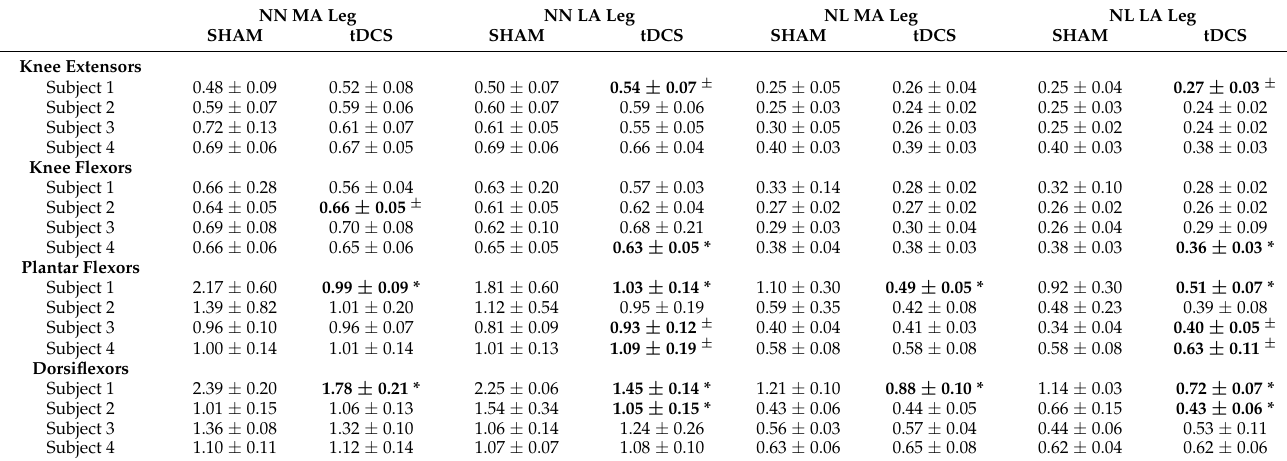
Table 2. Glucose standardized uptake values (SUV in g/mL) in leg muscle groups (knee extensors, knee flexors, plantar flexors, and dorsiflexors) after SHAM/tDCS and walking. The muscle group SUV means ± standard deviations were calculated from the individual muscles that comprise each functional muscle group. Non-normalized (NN) SUVs and SUVs normalized to the liver (NL) are